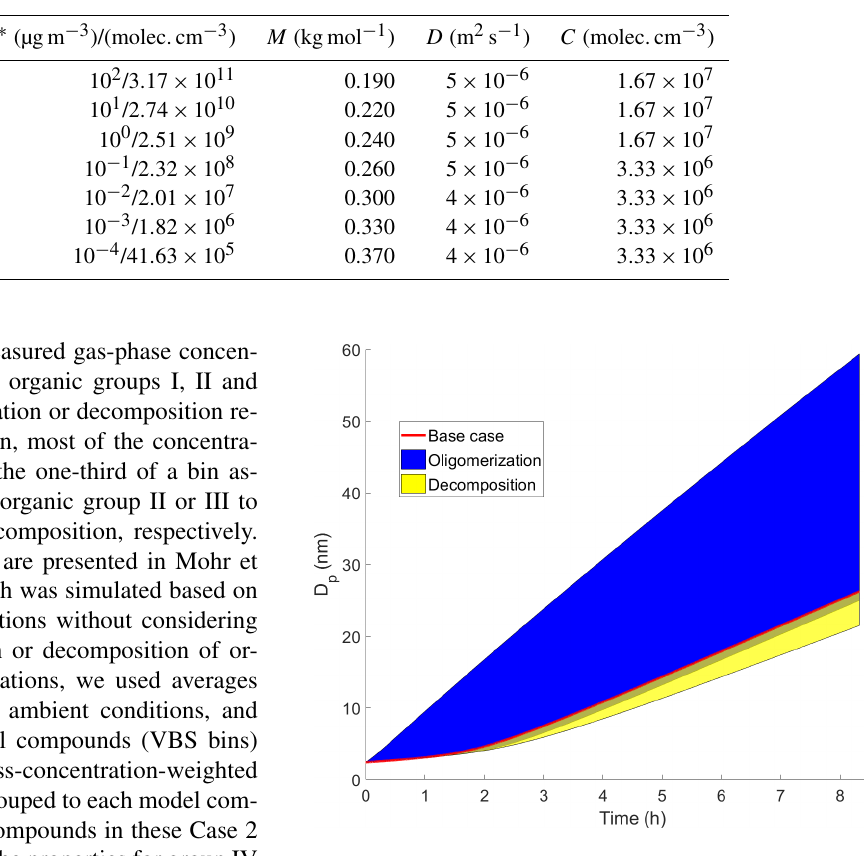
Figure 1. Diameter of the growing particle as a function of time in simulations based on artificial gas-phase concentrations (Case 1 simulations). The red line shows the base case simulation in which no particle-phase reactions were allowed. The blue area shows the contribution of oligomerization to the growth, i.e., the envelope of the simulations in which oligomerization was allowed. The yellow area shows the contribution of decomposition to the growth, i.e., the envelope of the simulations in which decomposition was